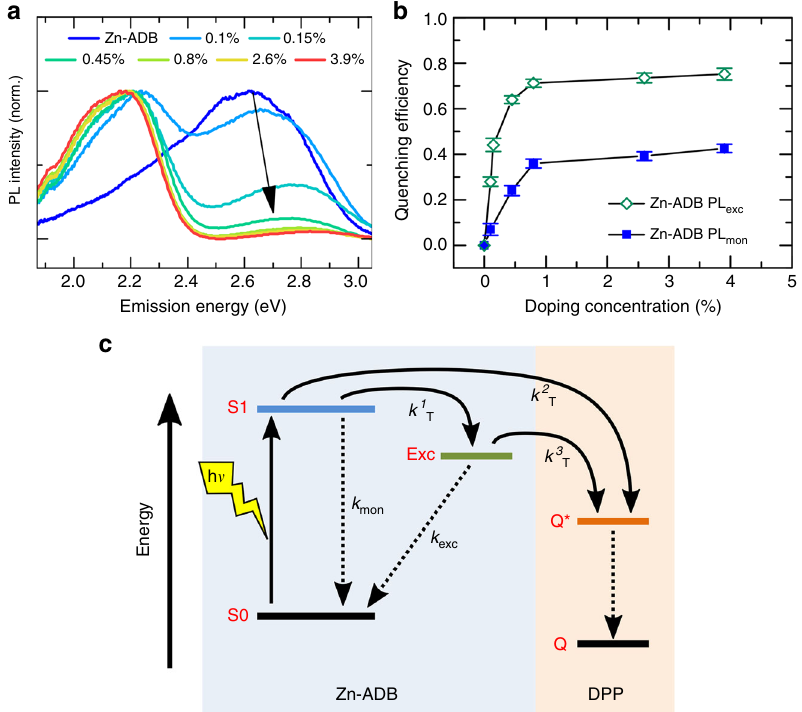
Fig. 3 Energy transfer in DA SURMOF-2. a Normalized PL spectra of the Zn-ADB (1) SURMOF-2 with different concentrations of DPP with excitation at 3.26 eV; with increasing % of DPP, the donor PL decrease. b Ef fi ciency of the excited states quenching as a function of the DPP concentration in the mixed- linker DA SURMOF-2 structures calculated from the PL lifetime of the individual excited states (Supplementary Table 1-2). The error bars are determined by propagating the uncertainties in the fi ts shown in Supplementary Fig. 16. c Excited state kinetics of the mixed-linker DA SURMOF-2 structures (also see Supplementary Fig. 15 and Table